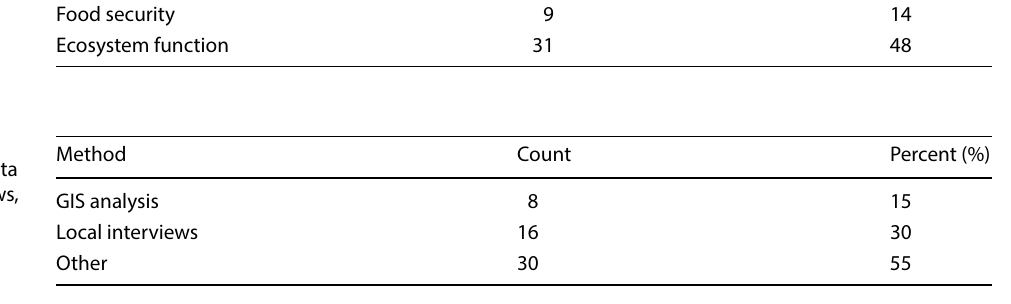
Table 3 Combinations of keyword search terms and number of results from Web of Science and